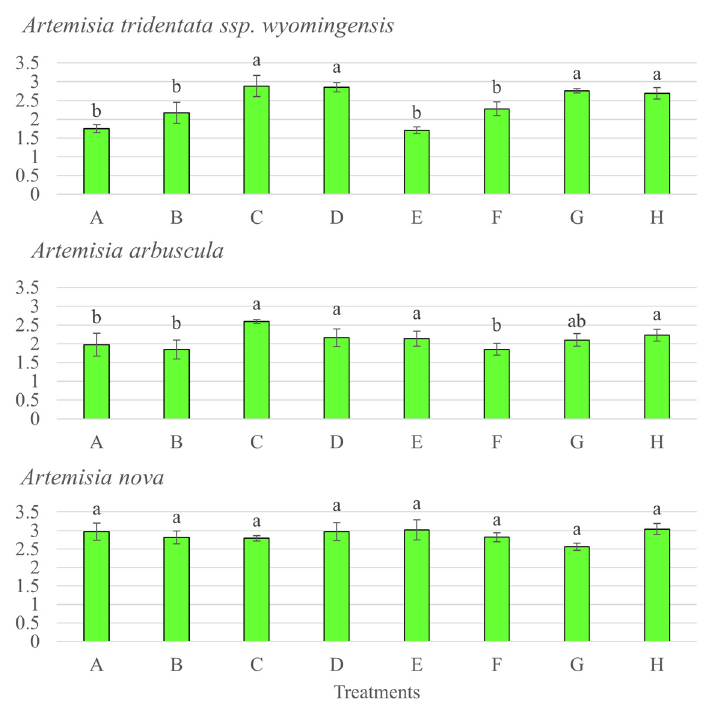
Figure 5. Nitrogen (N) concentration ± SE (error bars) in Artemisia tridentata ssp. wyomingensis , Artemisia arbuscula, and Artemisia nova . Different letters above bars indicate significant differences among treatments (Tukey’s HSD). N content of Artemisia species grown under competition not measured.